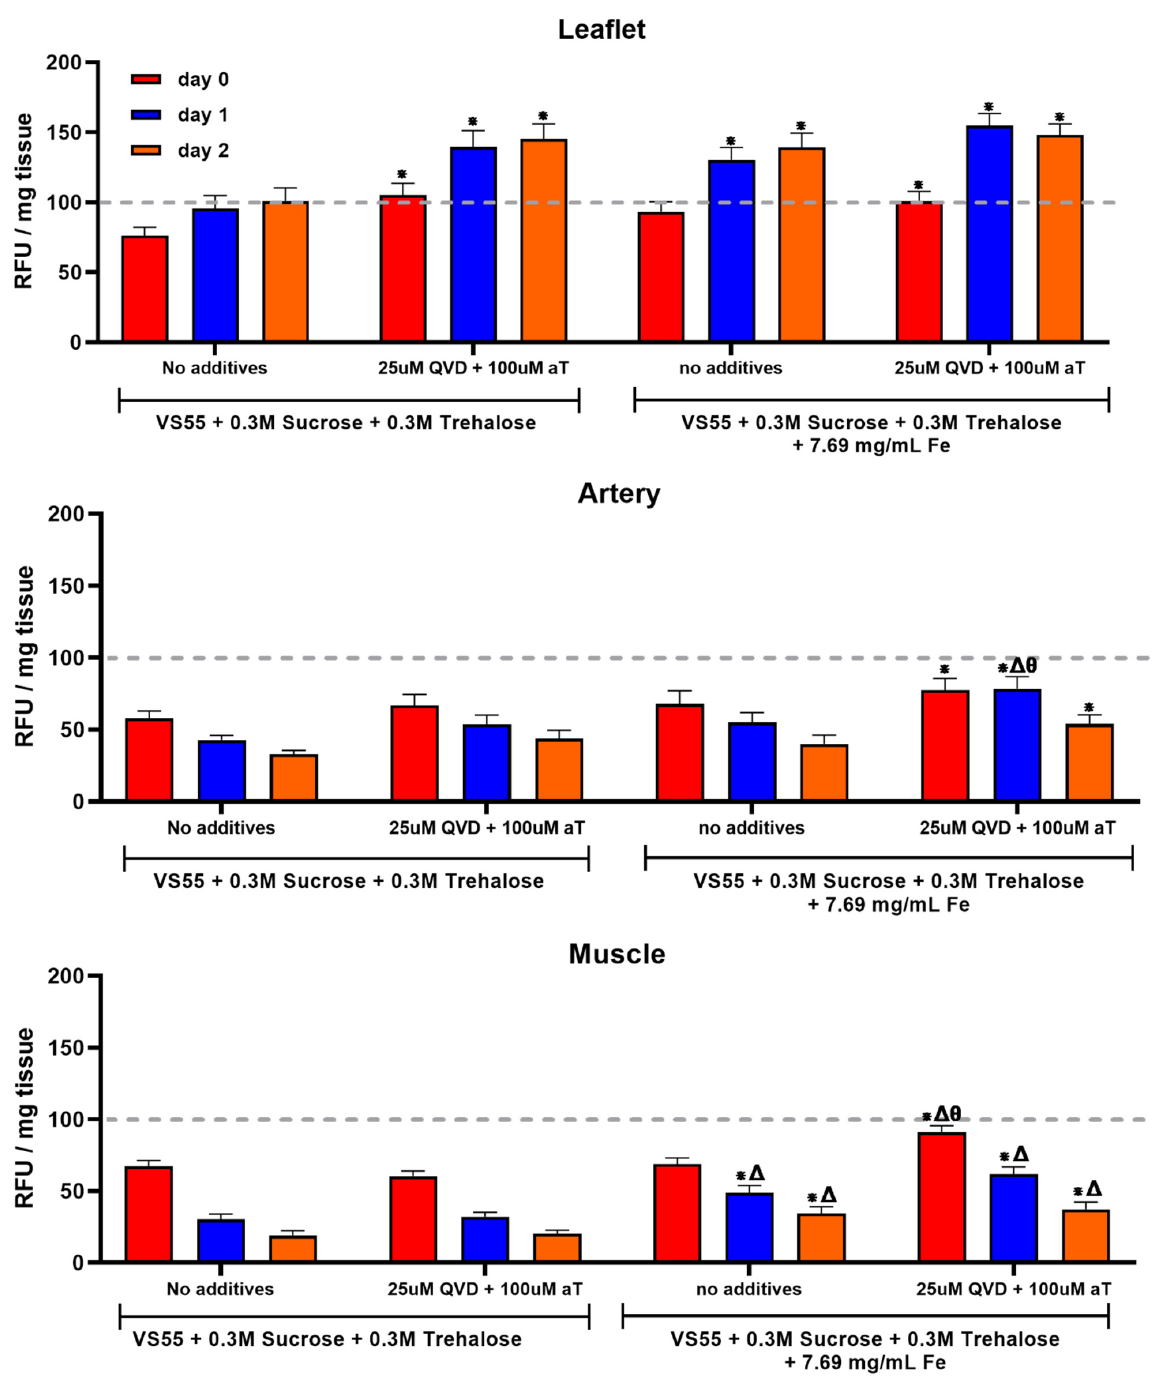
Figure 4. Impact of post-rewarming treatment with an apoptosis inhibitor and antioxidant upon tissue viability. Pulmonary valves were vitrified in VS55 + 0.3M sucrose and 0.3M trehalose and warmed using either conventional boundary warming ( left ) or nanowarming ( right ). The top graph in each case is the leaflet, the center is the pulmonary artery, and the bottom is the fibrous muscle band at the base of the heart valve. The heart valve tissue components were then cultured under physiological conditions with and without supplements, 25 µ M QVD and 100 µ M α -tocopherol, for 4 h, 24 h, and 48 h with viability assessment at each time point using alamarBlue. The results are shown as the mean ± 1 standard error, p < 0.05 * compared to no Fe or supplements, ∆ compared to supplements only, and θ compared with no supplements +